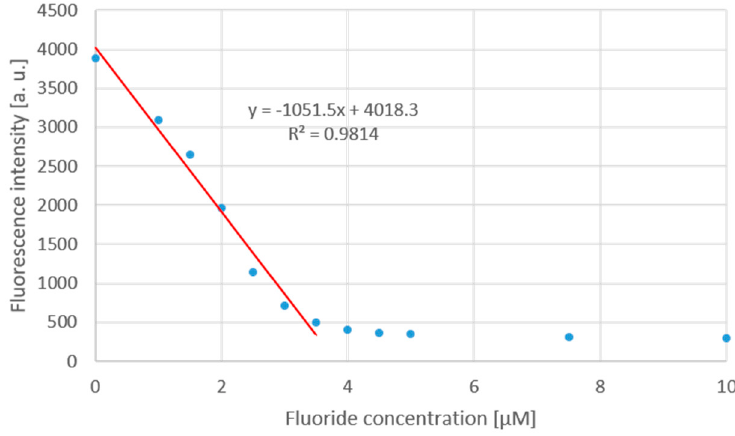
Figure 7. The loss of fluorescence intensity as a function of the fluoride concentration.